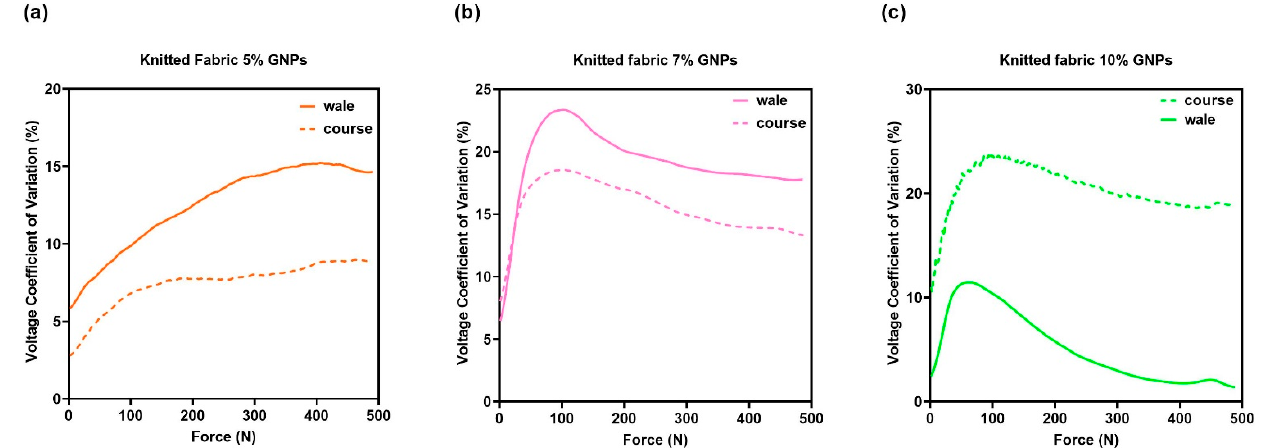
Figure 14. Voltage Coefficient of Variation (CV%) for ( a ) knitted fabric doped with 5% GNPs, whose active material was assembled towards the walewise (continuous line) and towards the coursewise directions (dotted line); ( b ) knitted fabric doped with 7% GNPs, whose active material was assembled towards the walewise (continuous line) and towards the coursewise directions (dotted line); ( c ) knitted fabric doped with 10% GNPs, whose active material was assembled towards the walewise (continuous line) and towards the coursewise directions (dotted line).